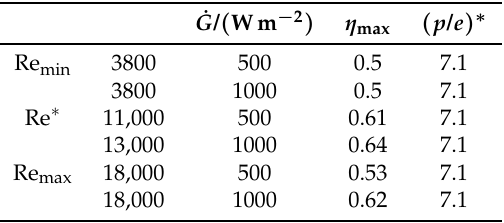
Table 16. Maximum efficiency and optimum roughness parameters according to the model developed by Gawande et al.